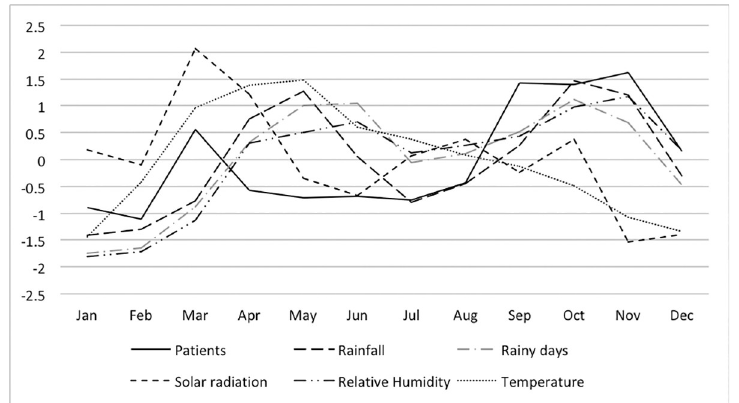
Fig 4. Monthly distribution of the standardized incidence of leptospirosis cases and meteorological parameters in the wet zone of Sri Lanka.